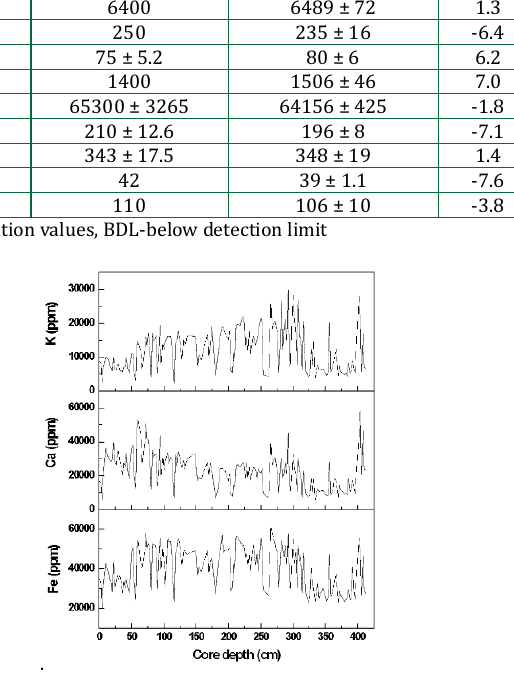
Figure 2: Down core variations of Fe, Ca and K